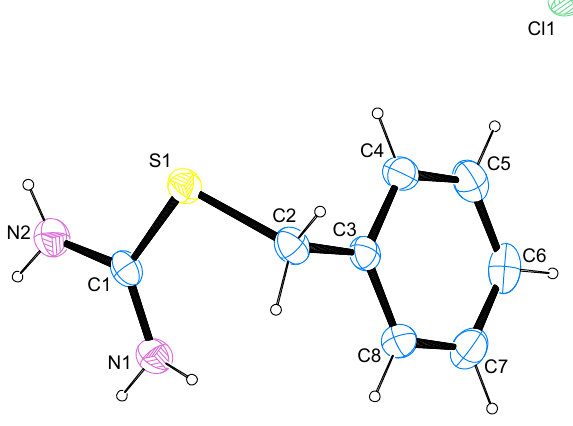
Table  : Fractional atomic coordinates and isotropic or equivalent isotropic displacement parameters (Å 